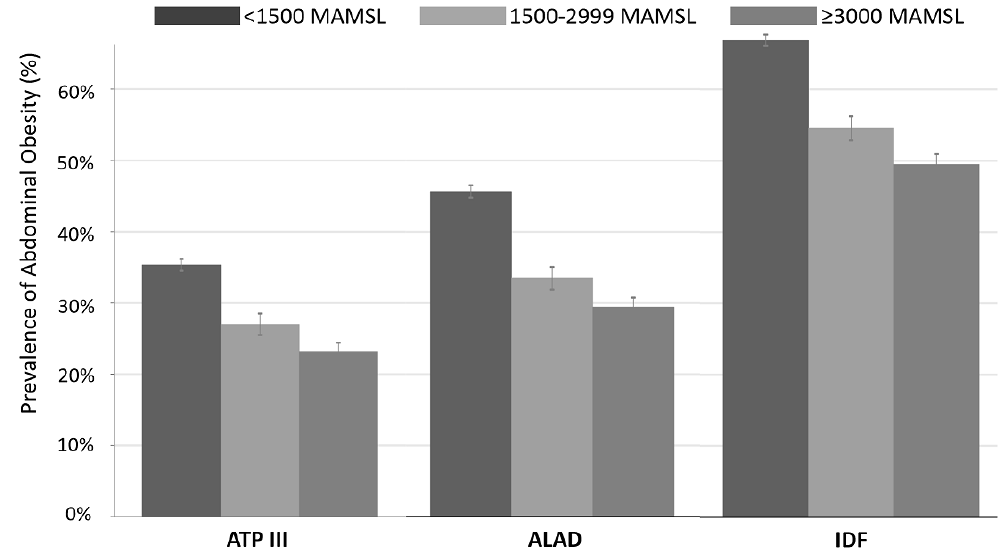
Figure 1. Prevalence of abdominal obesity by altitude and by different cutoffs. ATP III, Adult Treatment Panel III guidelines; ALAD, Latin- American Diabetes Association; IDF, International Diabetes Federation; MAMSL, meters above mean sea level.